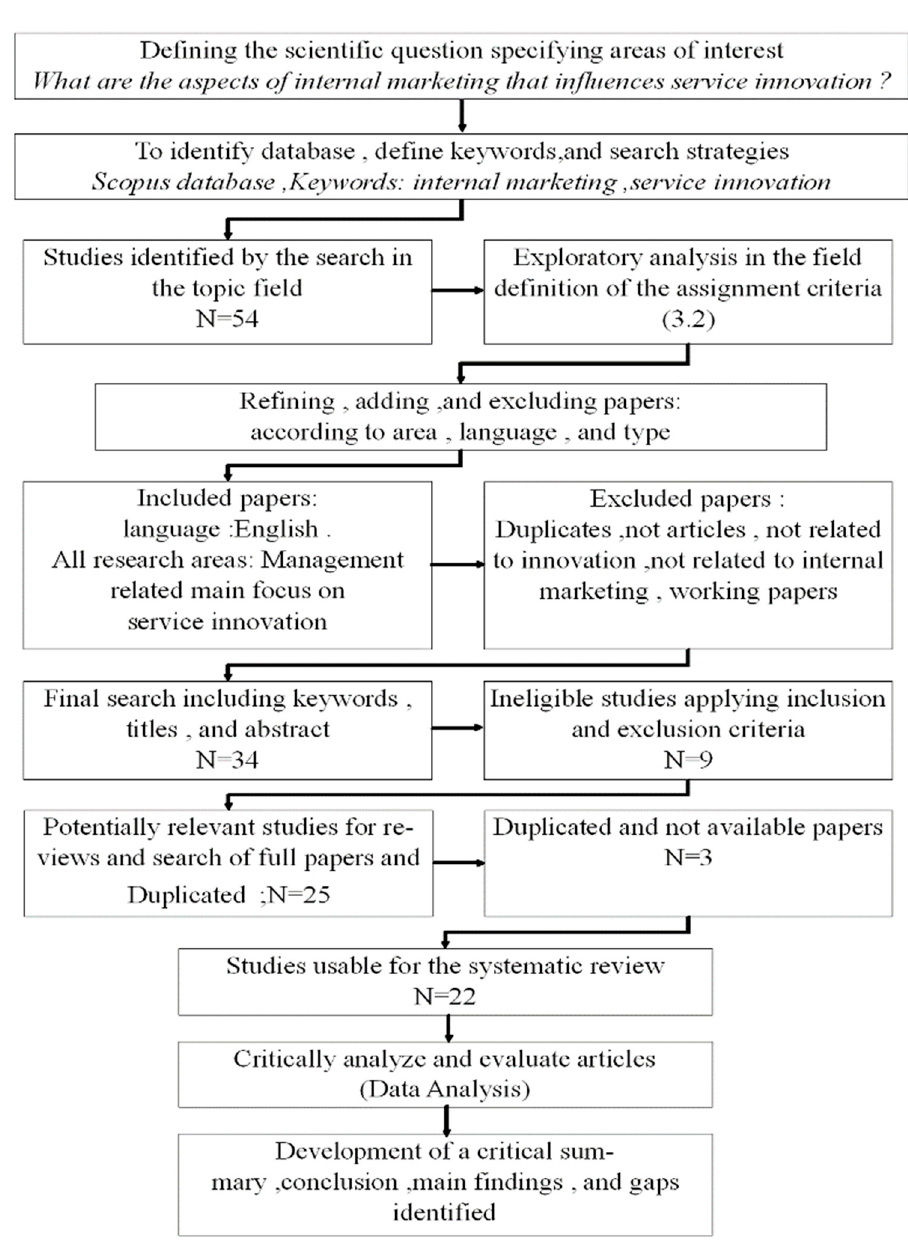
Figure 2. Systematic review—Procedures. Sources: Adapted from Bossle et al. (2016), Petticrew and Roberts (2006), and Sampaio and Mancini (2007).